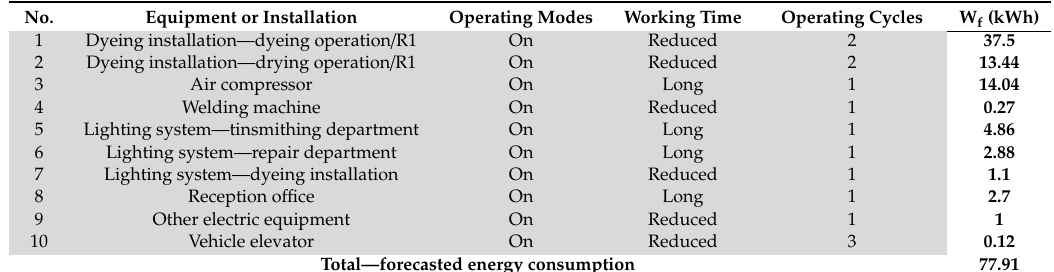
Table 10. The Decision Matrix and forecasted energy consumption for Tuesday.